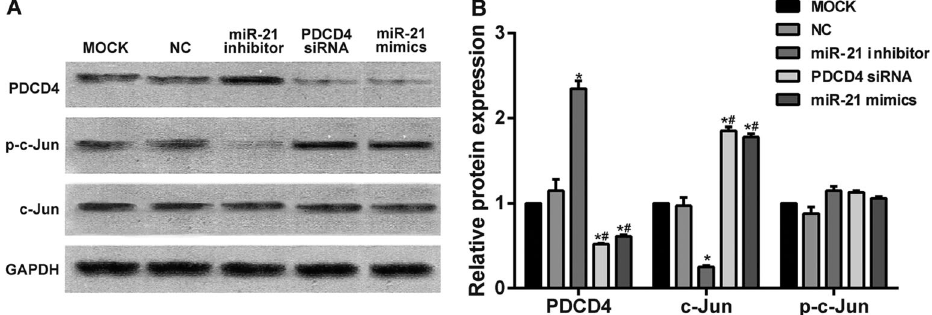
Figure 5. Programmed cell death 4 (PDCD4), c-Jun and p-c-Jun expressions after transfection. A , Western blot analysis of each group; B , comparison of PDCD4, c-Jun, and p-c-Jun expressions in each group. The expression of PDCD4 was decreased in both PDCD4 siRNA group and miR-21 mimics group, but the expression of c-Jun was elevated in both groups. The inhibition of miR-21 led to an increase of PDCD4 expression and decrease of c-Jun expression, while no differences in p-c-Jun expressions were detected among the fi ve groups. *P o 0.05, compared with blank control (MOCK) and negative control (NC) groups; # P o 0.05 compared with miR-21 inhibitor group. Comparisons among multiple groups were conducted using one-way ANOVA and pairwise comparisons were conducted using t-